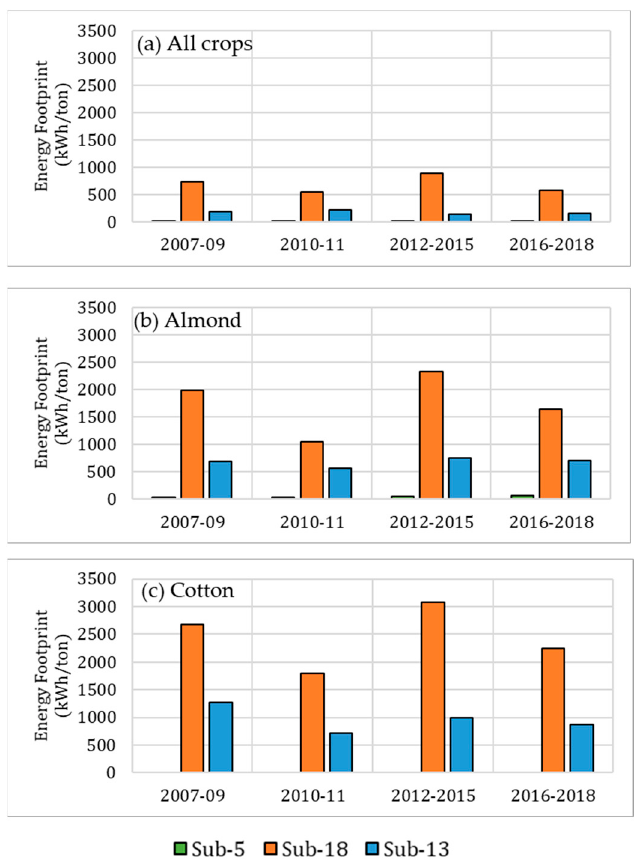
Figure 10. Energy Footprints in three study regions for ( a ) all crops, ( b ) almond, and ( c ) cotton.